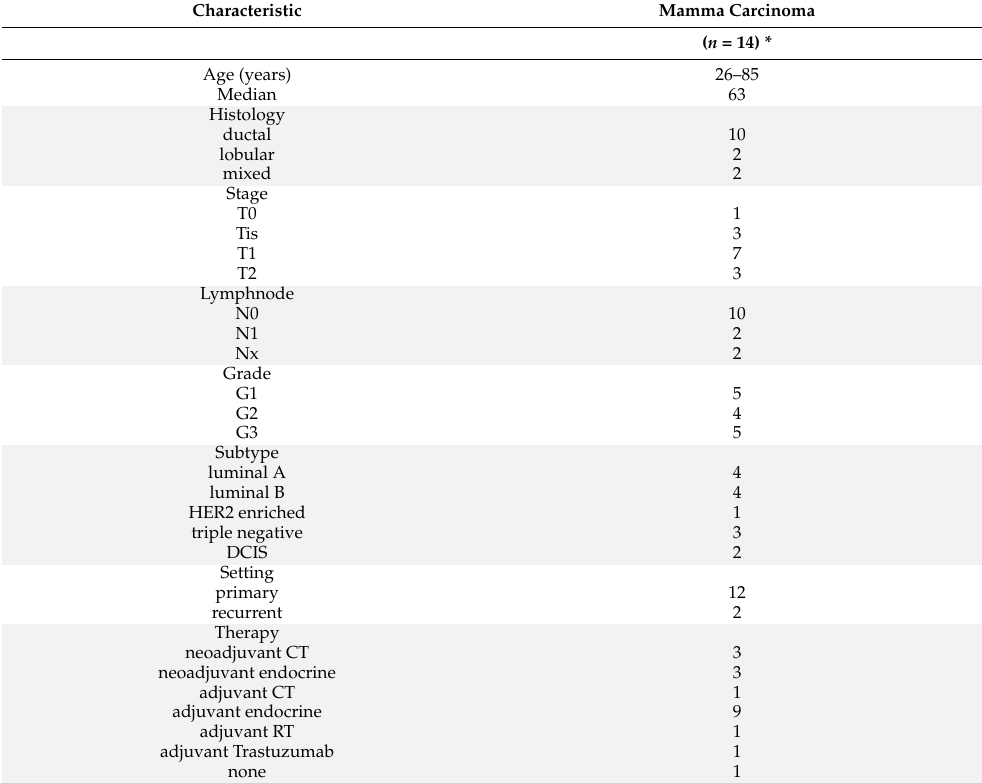
Table 1. Clinico-pathological characteristics. Patients were included after agreeing and signing a written informed